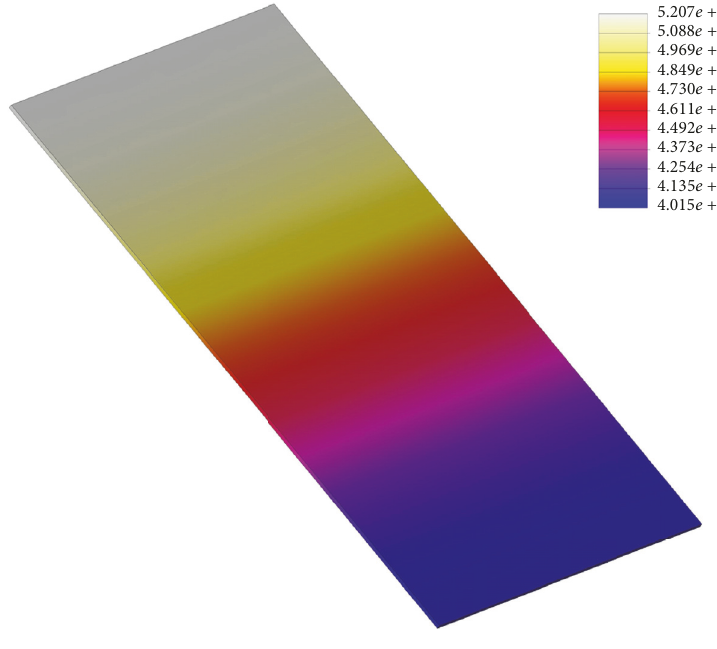
Figure 17: The temperature distribution for the PV module ALTIUS 235W.